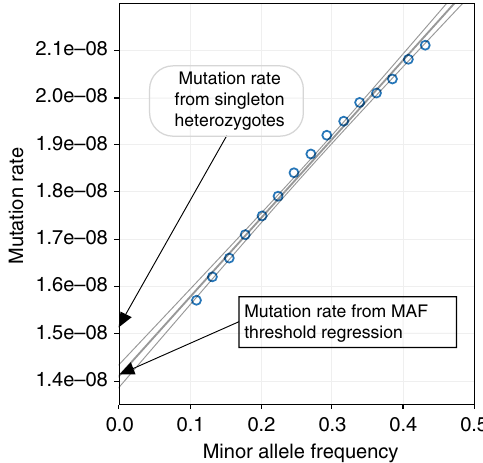
Fig. 2 MAF-threshold regression to simultaneously obtain mutation rate and gene conversion rate. The mutation rate, is calculated by obtaining values of N f at different thresholds of minor allele frequency. The intercept on the y axis of the regression provides an estimate of the mutation rate that is corrected for gene conversion and the slope is used to calculate the estimate of the gene conversion